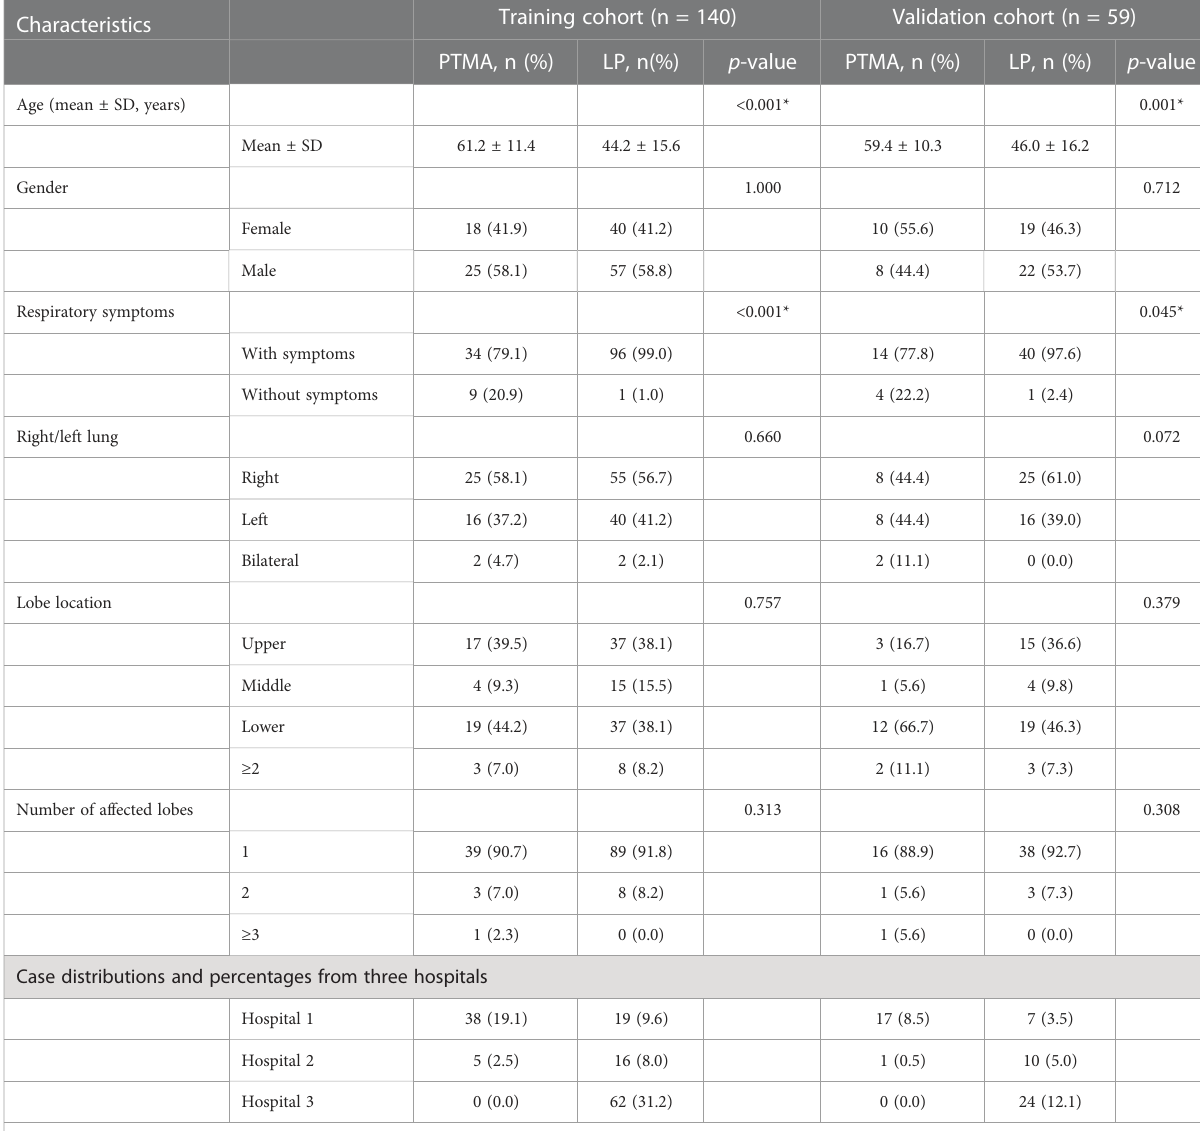
TABLE 2 Clinical and radiological parameters of patients in the training and validation cohorts.